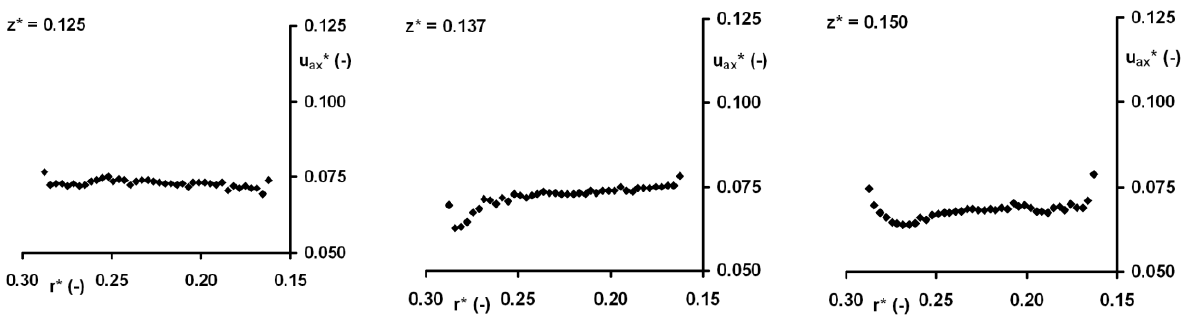
Fig. 9. Dimensionless axial fluctuation velocity profiles ) / ( N D u